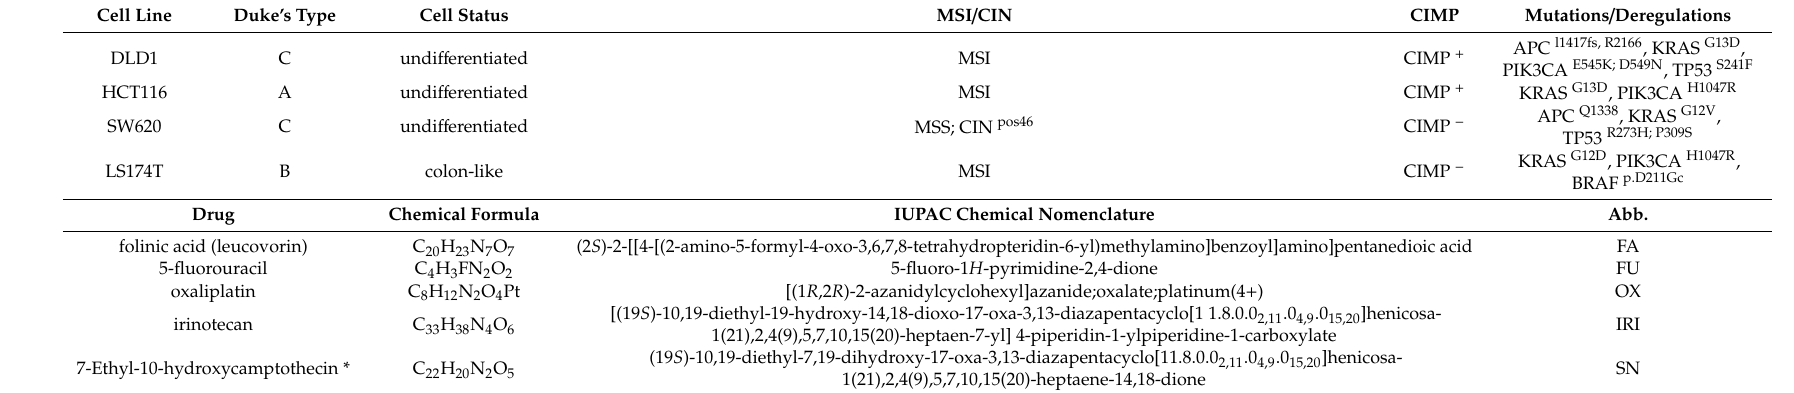
Table 1. CRC cell lines and drugs used in the study and their characterization